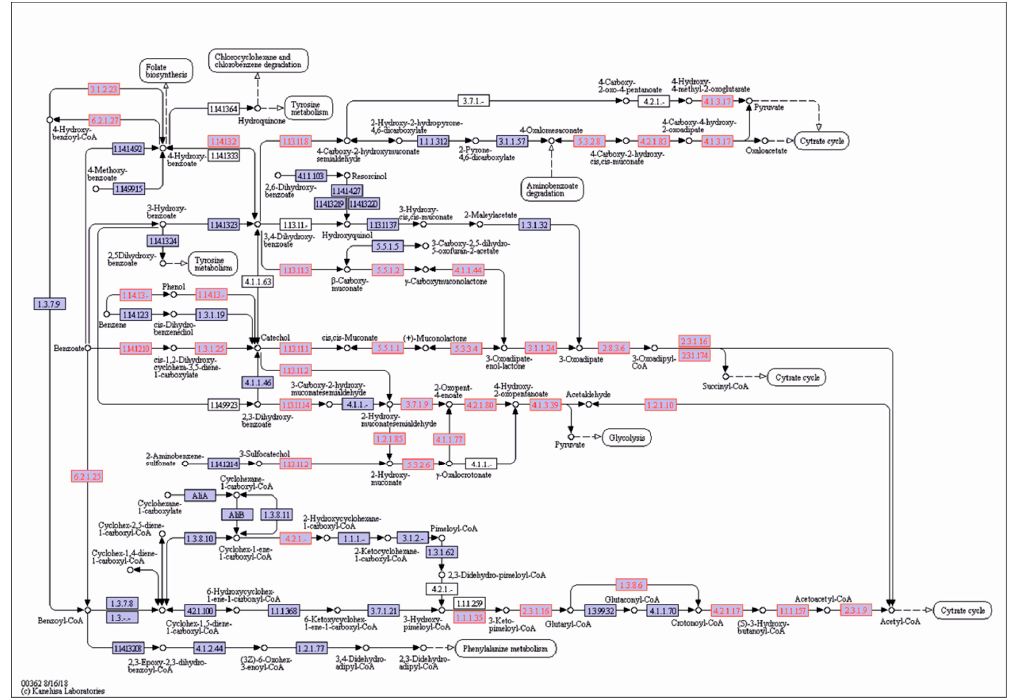
Figure 7. Locations of catabolic genes identified in P. putida OR45a (marked in pink) in the general microbial metabolic pathway for degradation of aromatic compounds.